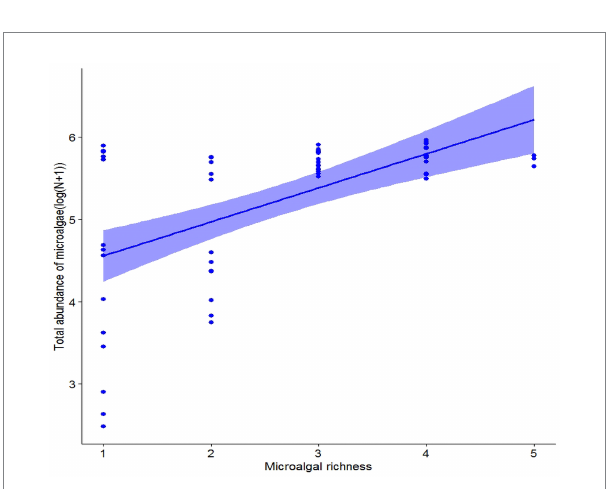
FIGURE 3 The relationship between microalgal richness and the total abundance of